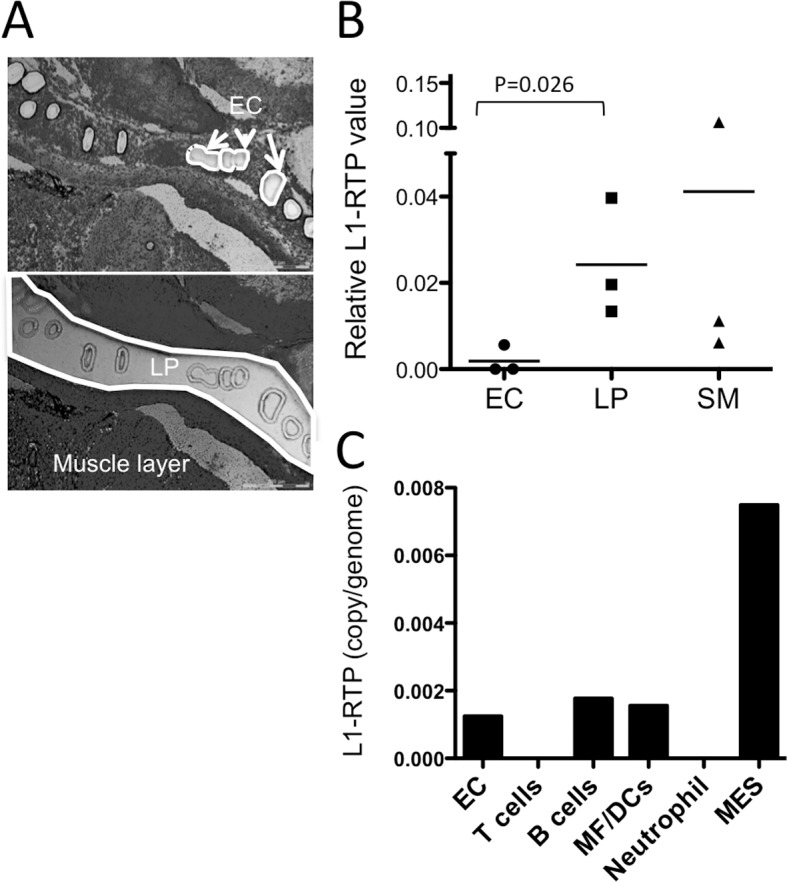
Cell type-specific L1-RTP levels in acute colitis mice.(A) Representative photograph of a section after microdissection for epithelial cells (EC, top), lamina propria (LP, bottom) and the remaining tissues (including submucosa and muscle layer) of colon section by laser microdissection. (B) L1-RTP levels were analyzed in colonic ECs, the LP, and the submucosa plus muscle layer (SM) isolated by microdissection from mice in the acute colitis phase. The relative L1-RTP value was normalized by using ß-actin as an internal control. Each plot indicates an individual mouse. P values were calculated with an unpaired one-tailed t test. (C) L1-RTP levels were examined in isolated ECs or sorted EpCAM negative-gated non-EC fractions by flow cytometry from mice in the acute colitis phase, as follows: T cells (EpCAM-CD3+), B cells (EpCAM-B220+), macrophage/dendritic cells (MΦ/DCs, EpCAM-CD11b+/CD11c+/F4/80+), Neutrophils (EpCAM-Gr-1+) and other cell types, most likely mesenchymal cells (MES, EpCAM-CD3-B220-CD11b-CD11c-F4/80-Gr-1-). Levels of L1-RTP from pooled cell fractions obtained from four mice are shown.